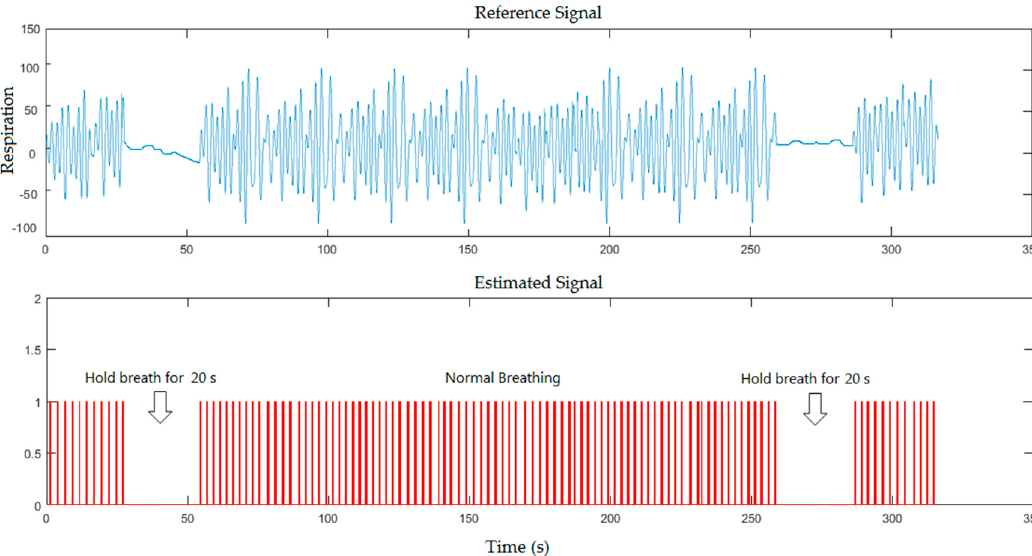
Figure 7. A five minutes simulation for healthy subject where the subject was asked to hold his breath twice during the measurement for the second scenario (without a blanket).